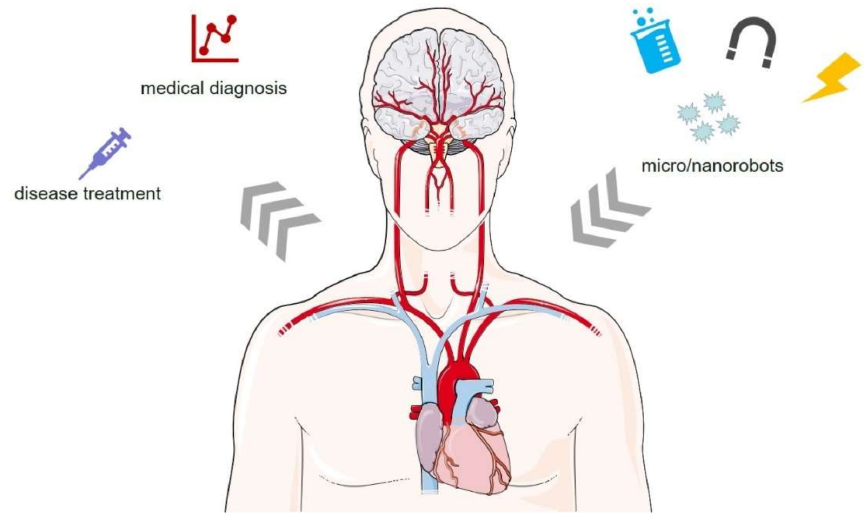
Figure 1. Schematic view of micro/nanorobots for medical diagnosis and disease